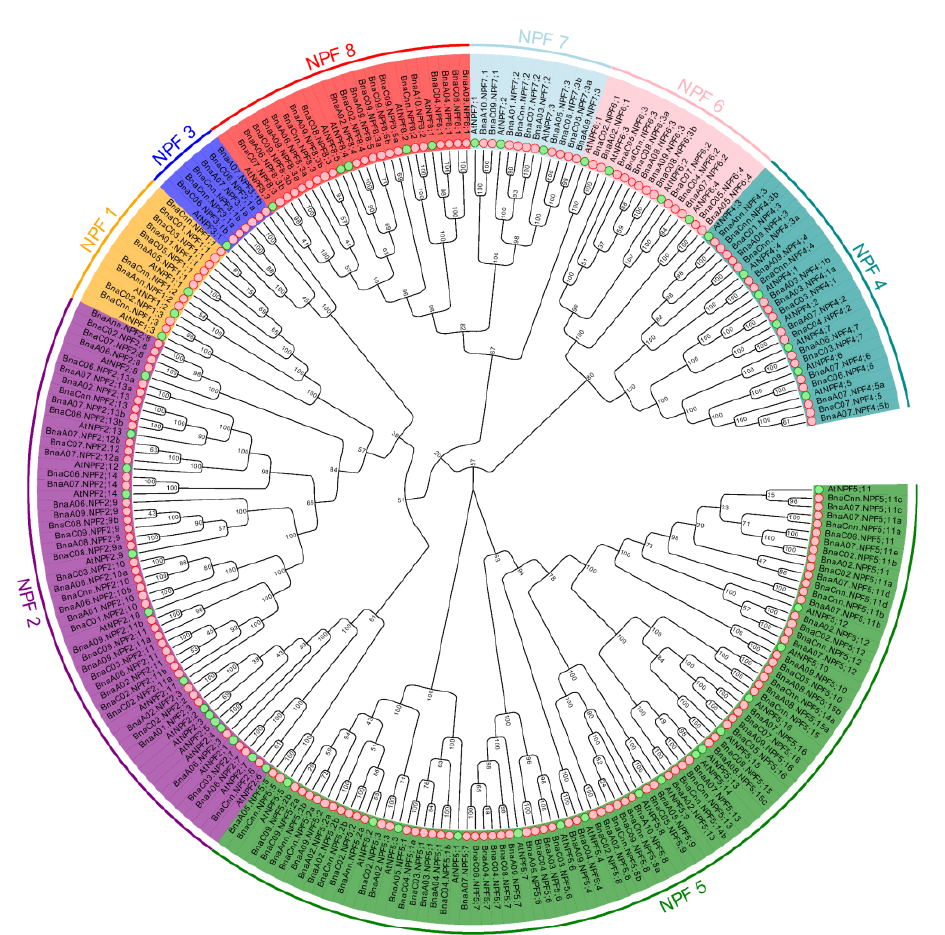
Figure 1. Phylogenetic tree of coding nucleotide sequences of the NITRATE TRANSPORTER 1 (NRT1) / PEPTIDE TRANSPORTER (PTR) family (NPF) in Brassica napus and Arabidopsis thaliana . The phylogenetic tree was constructed by Molecular Evolutionary Genetics Analysis (MEGA) 5.1 with neighbor-joining method and 1000 replicates. A total of 246 nucleotide sequences including 193 from B. napus (pink circular), and 53 from Arabidopsis (green circular) were involved in the analysis.